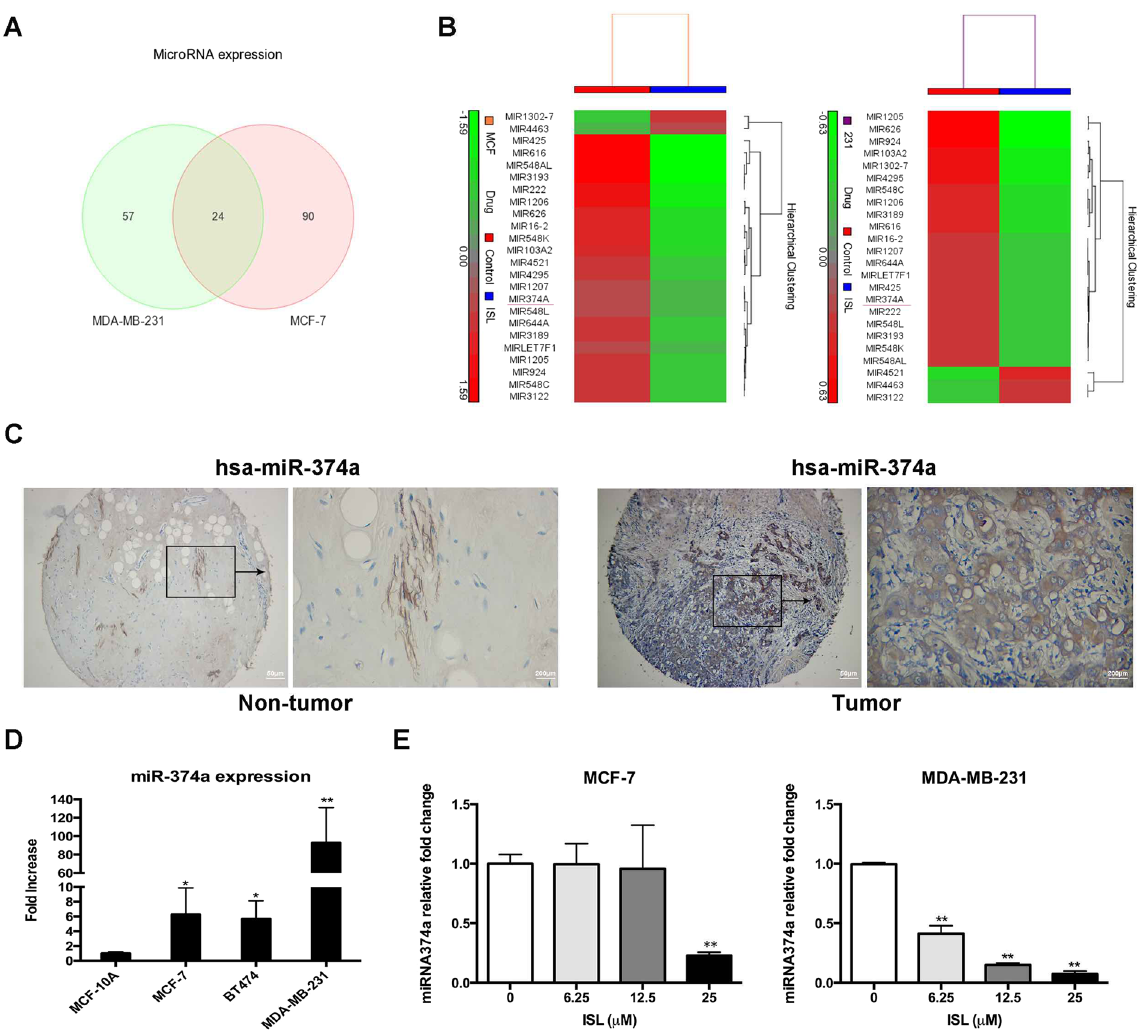
Figure 3. MiR-374a is highly expressed and attenuated by ISL in breast cancer. ( A , B ) Microarray analysis of miRNAs differences after 24 h ISL treatment in MCF-7 and MDA-MB-231. ( C ) ISH analysis of miR-374a expression in tumor tissues and matched normal tissues from breast cancer patients. ( D ) qRT-PCR analysis of miR-374a levels in human cancer cell lines and spontaneously immortalized MCF-10A cells. ( E ) qRT-PCR analysis of differently expressed miR-374a levels at the indicated concentrations of ISL.